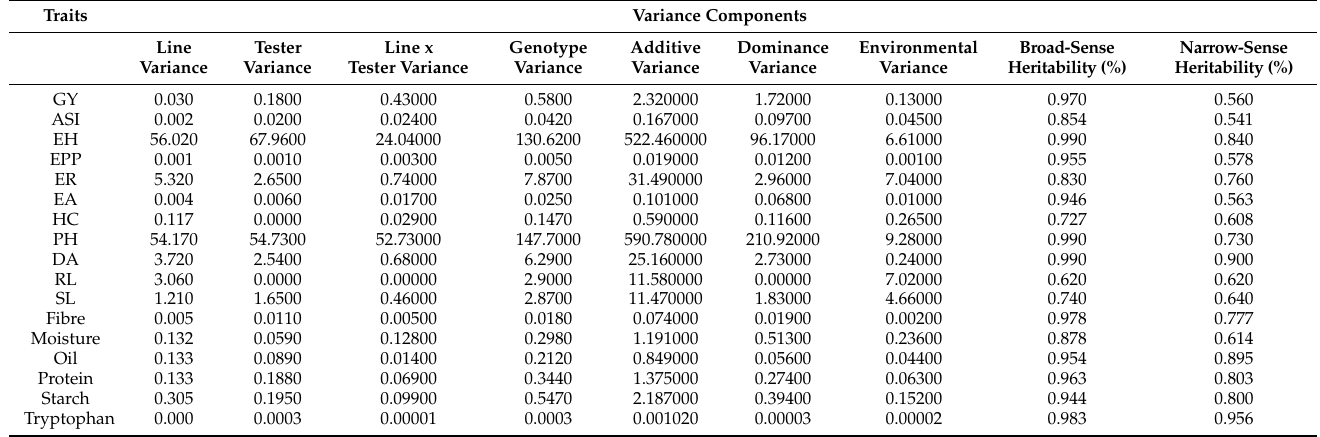
Table 1. Estimates of variance components and heritability for grain yield, and agronomic and quality traits of maize